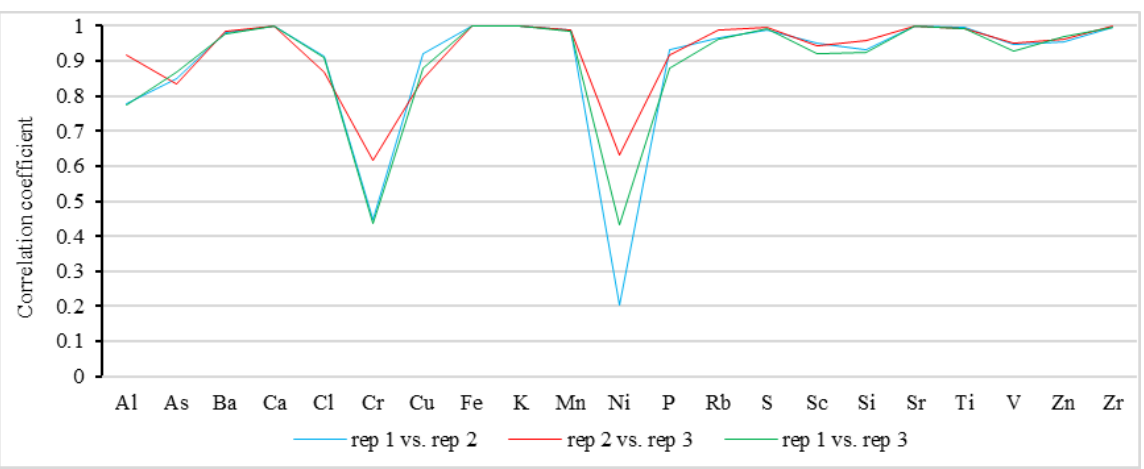
Figure 5. Similarity between the analysis results of pXRF and laboratory. The 40 s, 80 s, 120 s, and 200 s are the results of rock powder samples reported by pXRF.